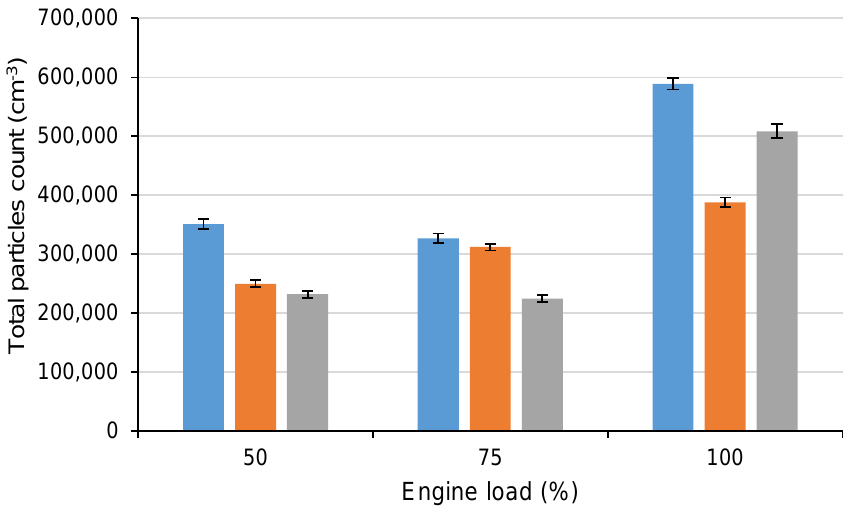
Figure 12. Total count of particles in relation to engine load for all tested fuels (error bars represent the standard deviation).